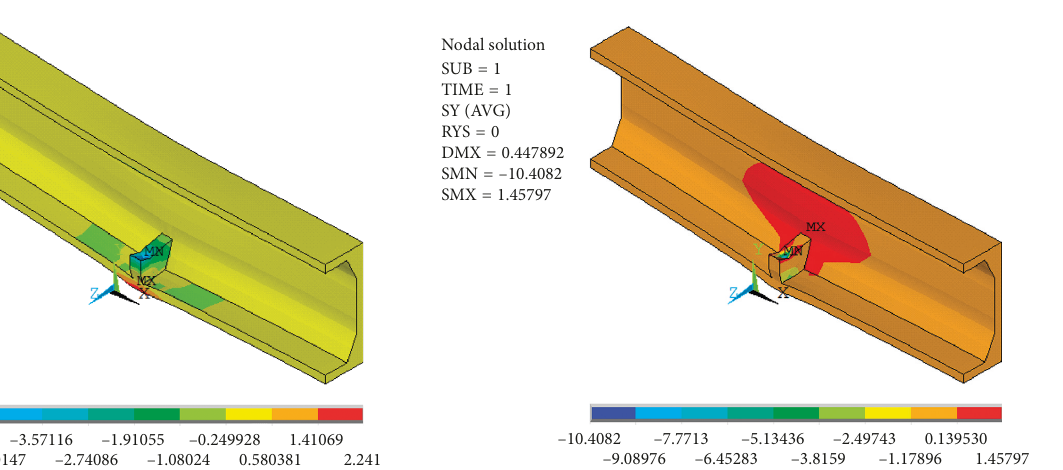
Figure 13: Cross stress distribution in the bottom slab of the arch rib.